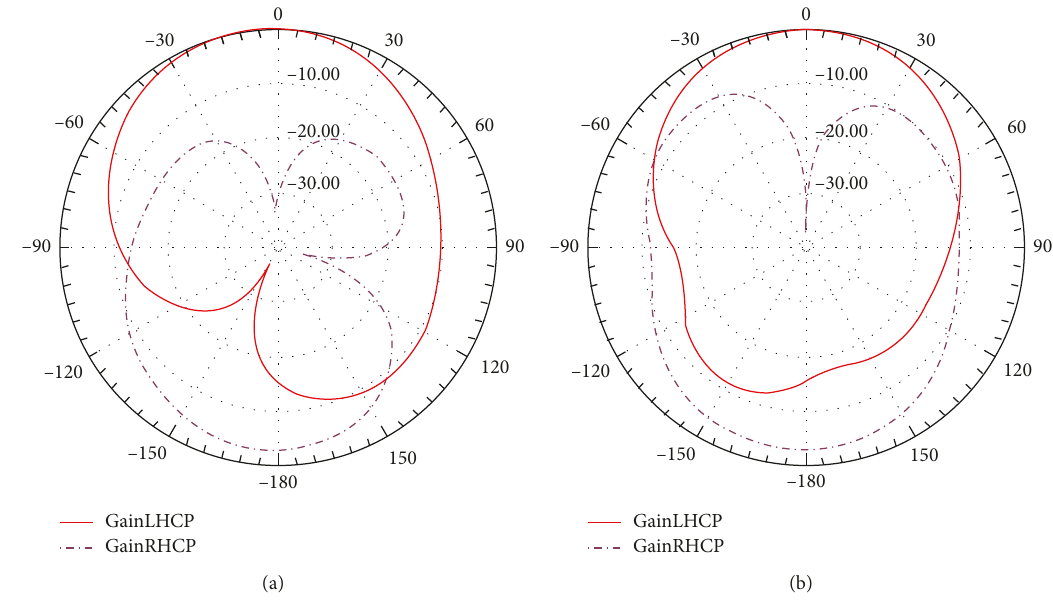
Figure 18: Simulated normalized radiation patterns at